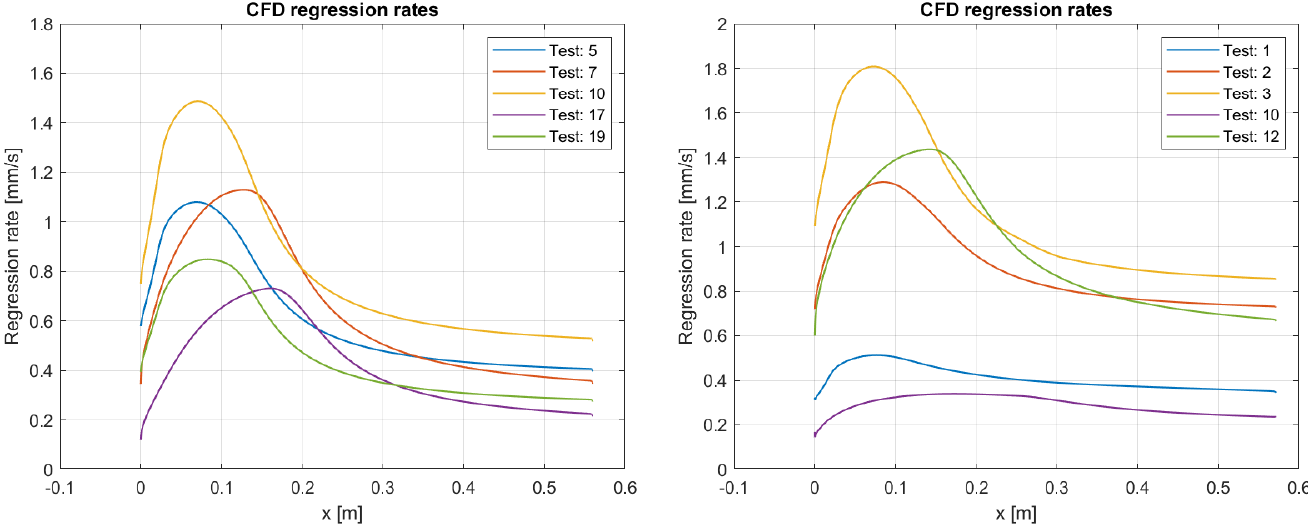
Figure 6. Regression rate profiles for simulations with HDPE ( left ) and HTPB ( right